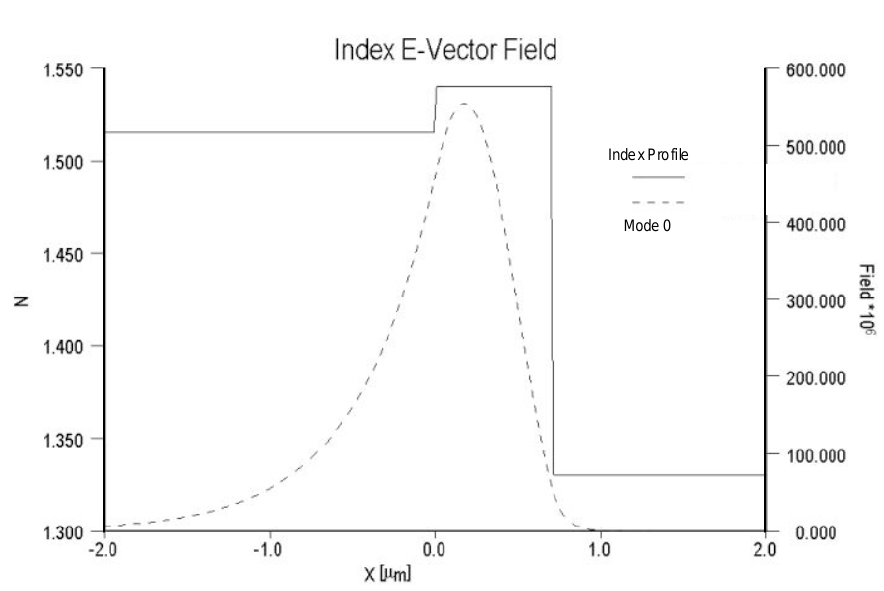
Figure 5. Electric field distribution of a high-contrast